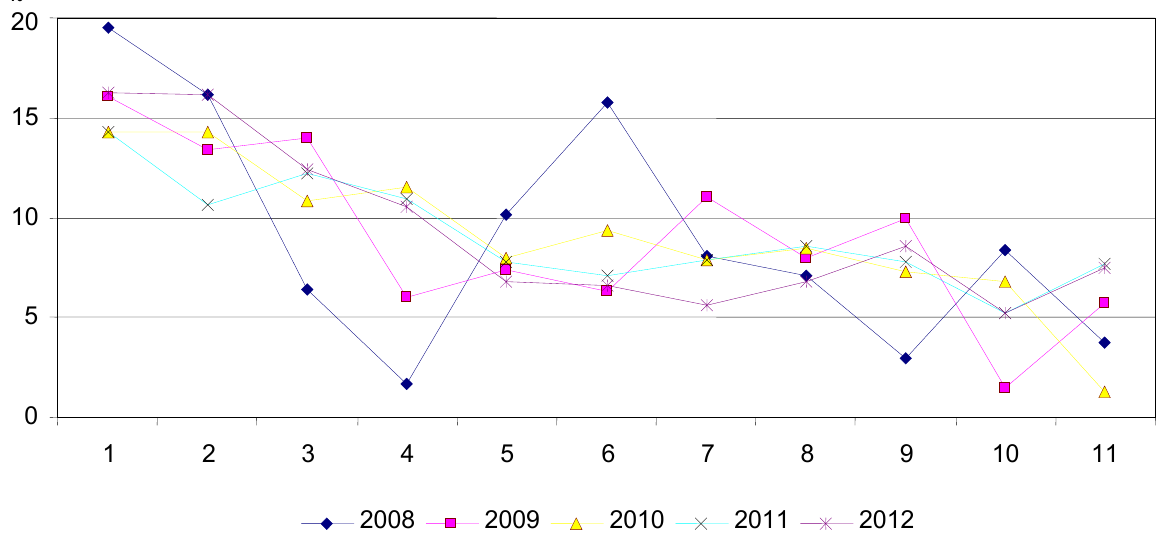
Fig.2. Percentage correlation of healthy 1-11 forms pupils for period 2008-2012,